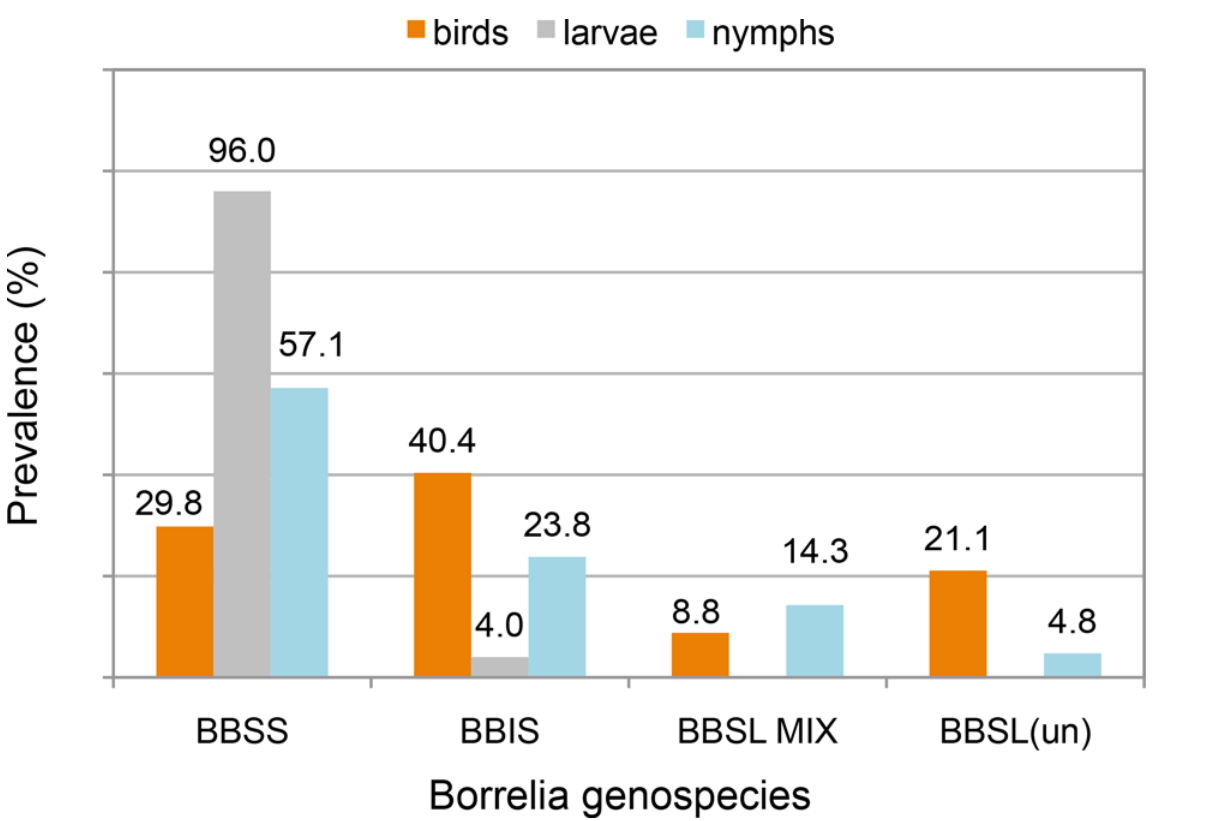
Fig 1. Prevalence (by %) of infection of birds, I . pacificus larvae and nymphs with different genospecies of Borrelia